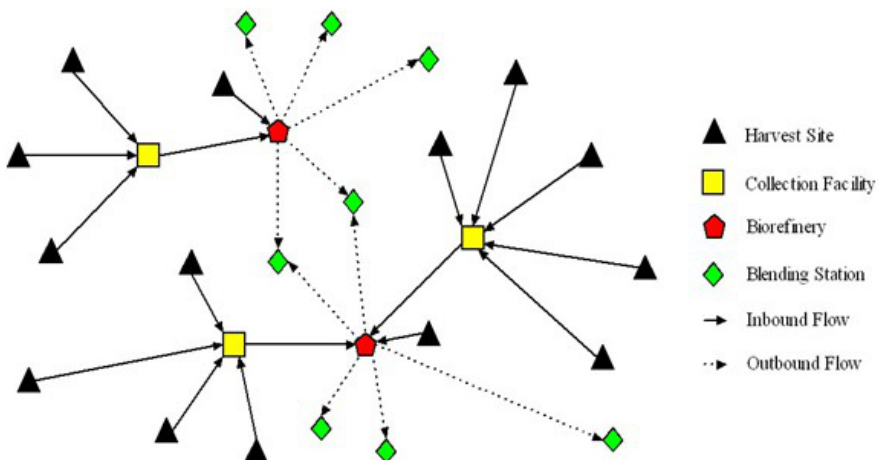
Figure 1. Schematic of Biomass/Bio-Energy Logistics